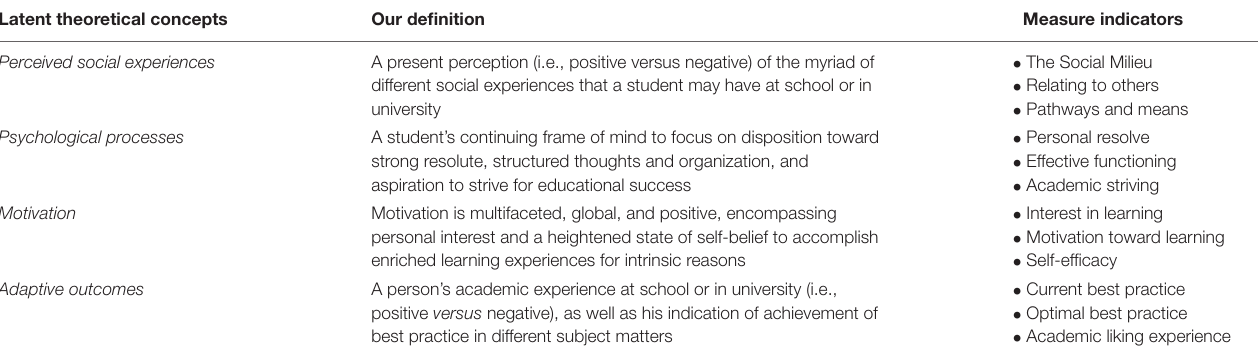
TABLE 2 | Latent theoretical concepts, definitions, and measured